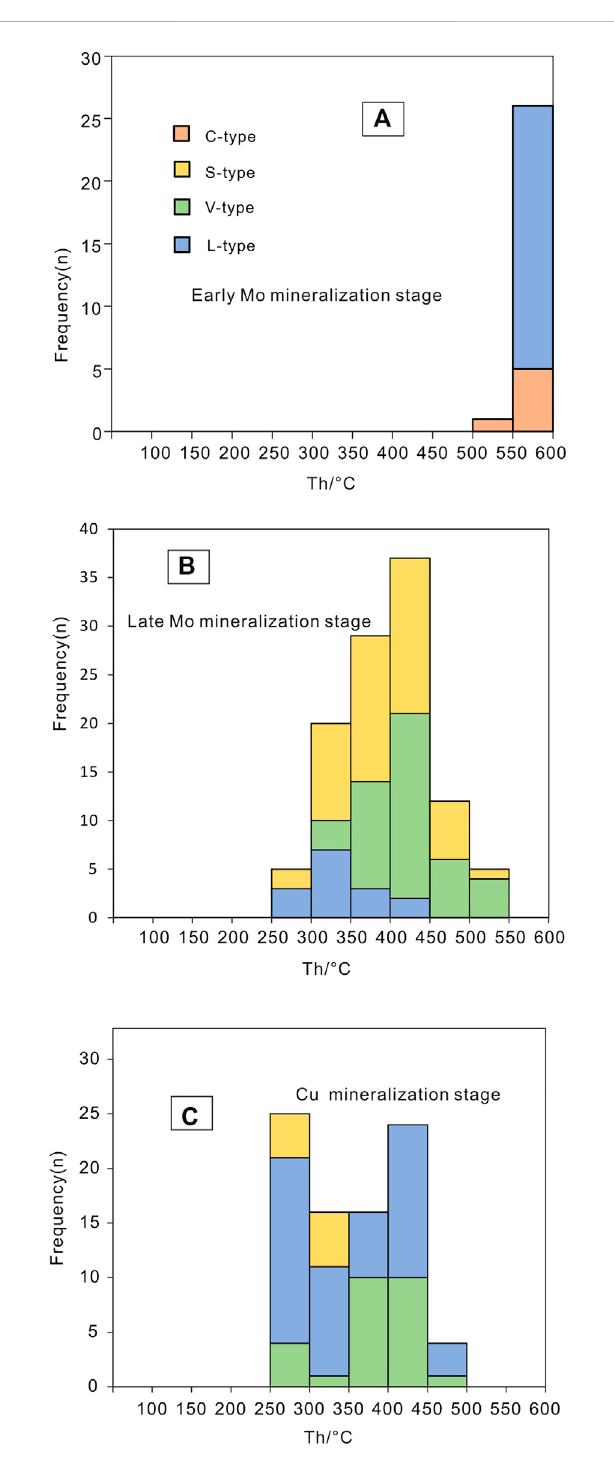
FIGURE 7 Frequency histograms of total homogenization temperatures (Th) for fl uid inclusions in different stages. (A) early Mo mineralization stage; (B) late Mo mineralization stage; (C) Cu mineralization stage.